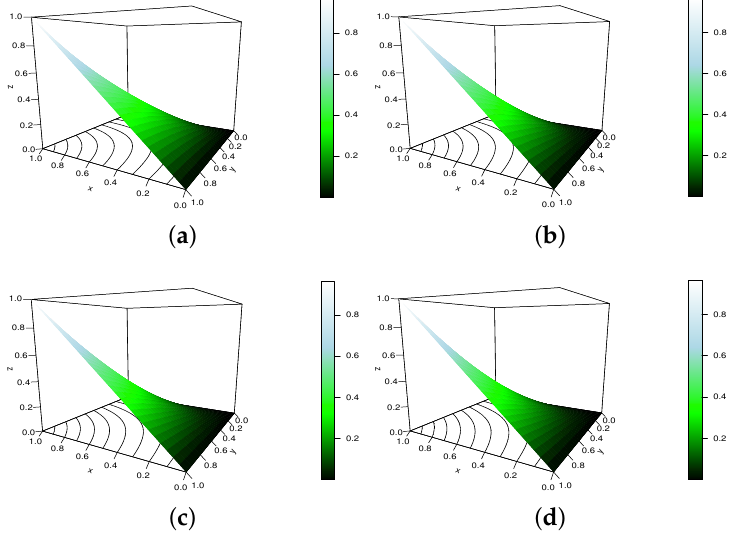
√ γ , and ( a ) γ = 1, ( b ) γ = 1.5, ( c ) γ = 2 and